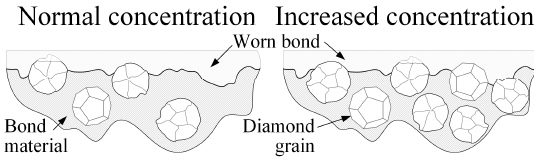
Figure 3. Schematic for variations in grain concentration.